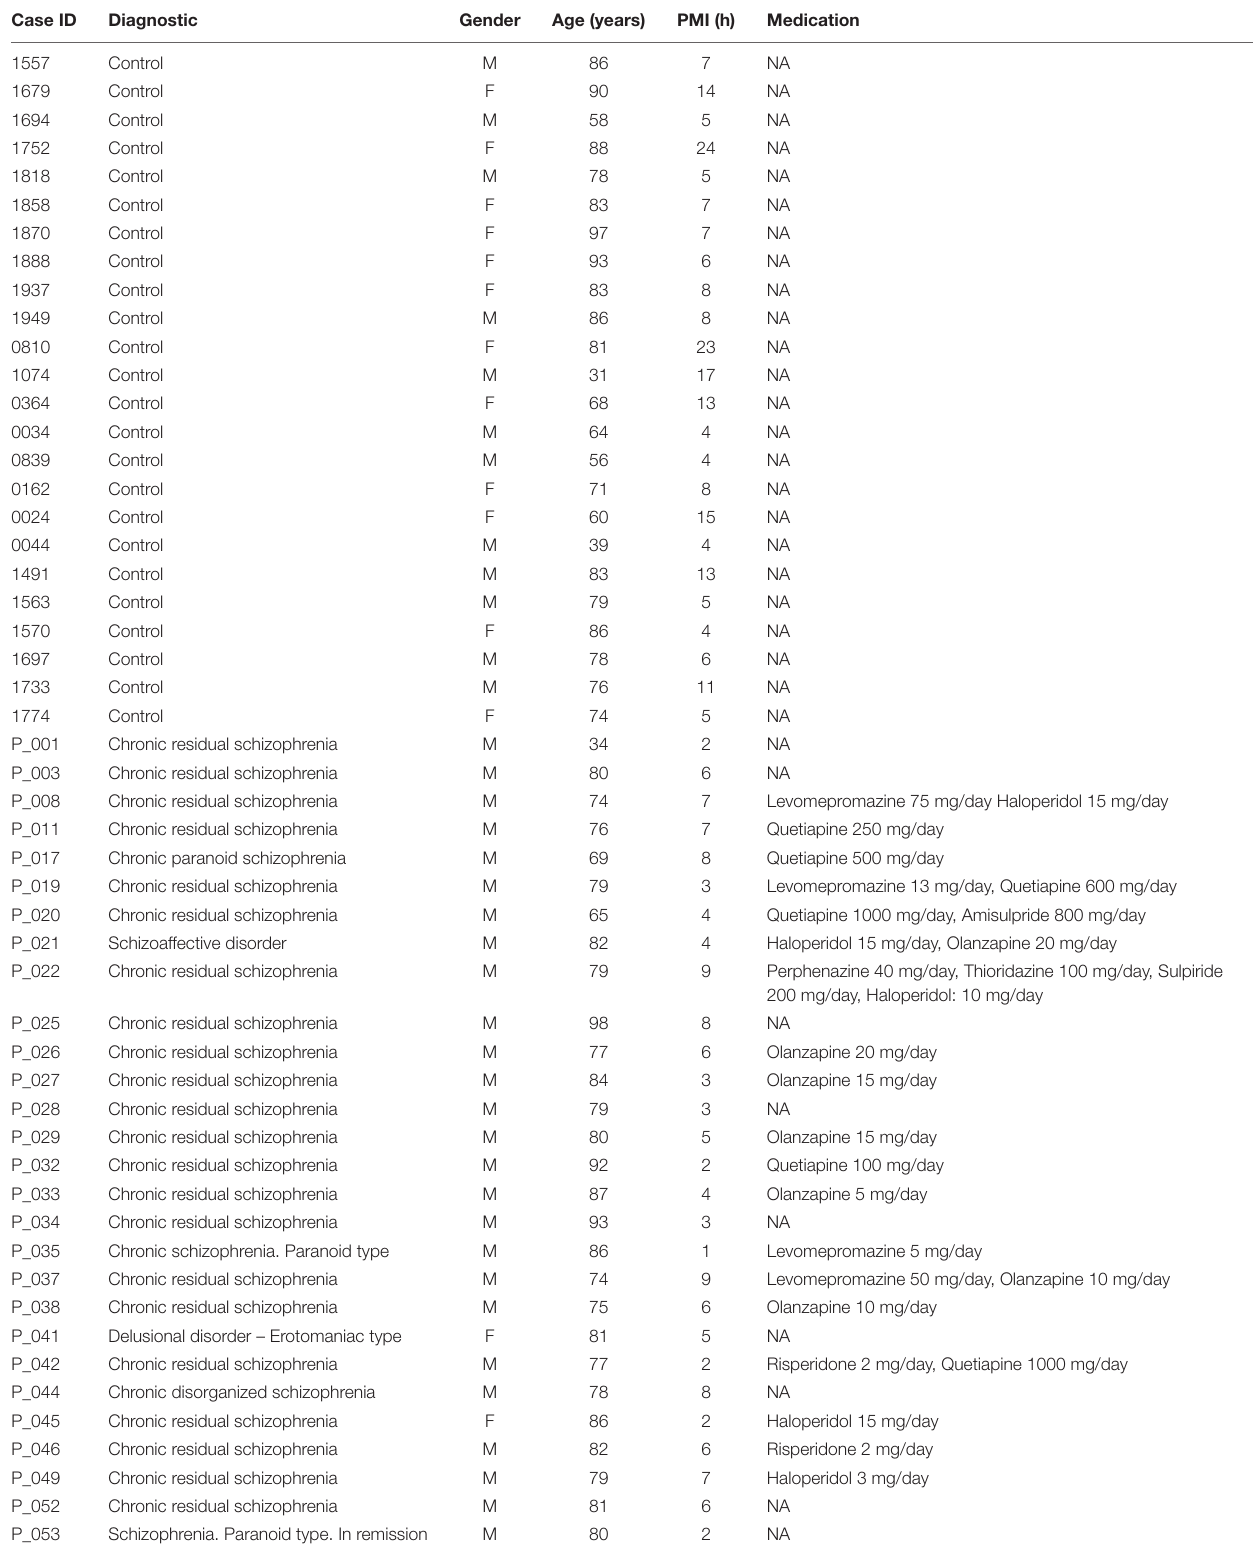
TABLE 1 | Demographics, treatments, and illness details for human post-mortem samples from patients with schizophrenia and controls. Case ID Diagnostic Gender Age